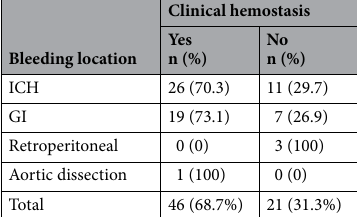
Table 2. Bleeding management outcome. ICH intracerebral hemorrhage, GI gastrointestinal.